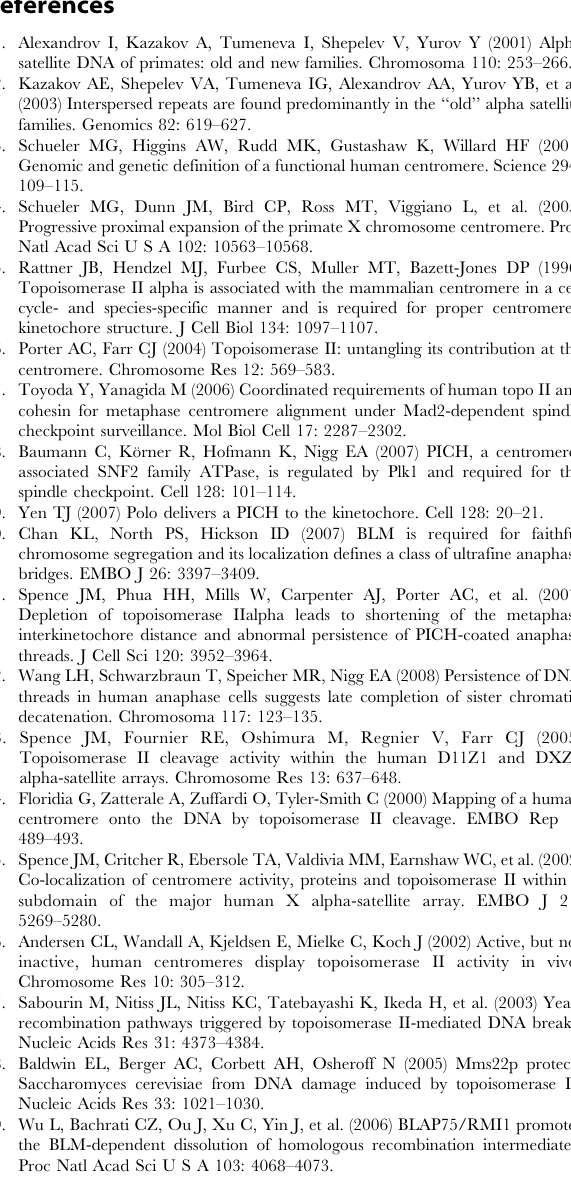
Table S5 Similarity between 3 kb of the most distal part of the grey domain in various primates.